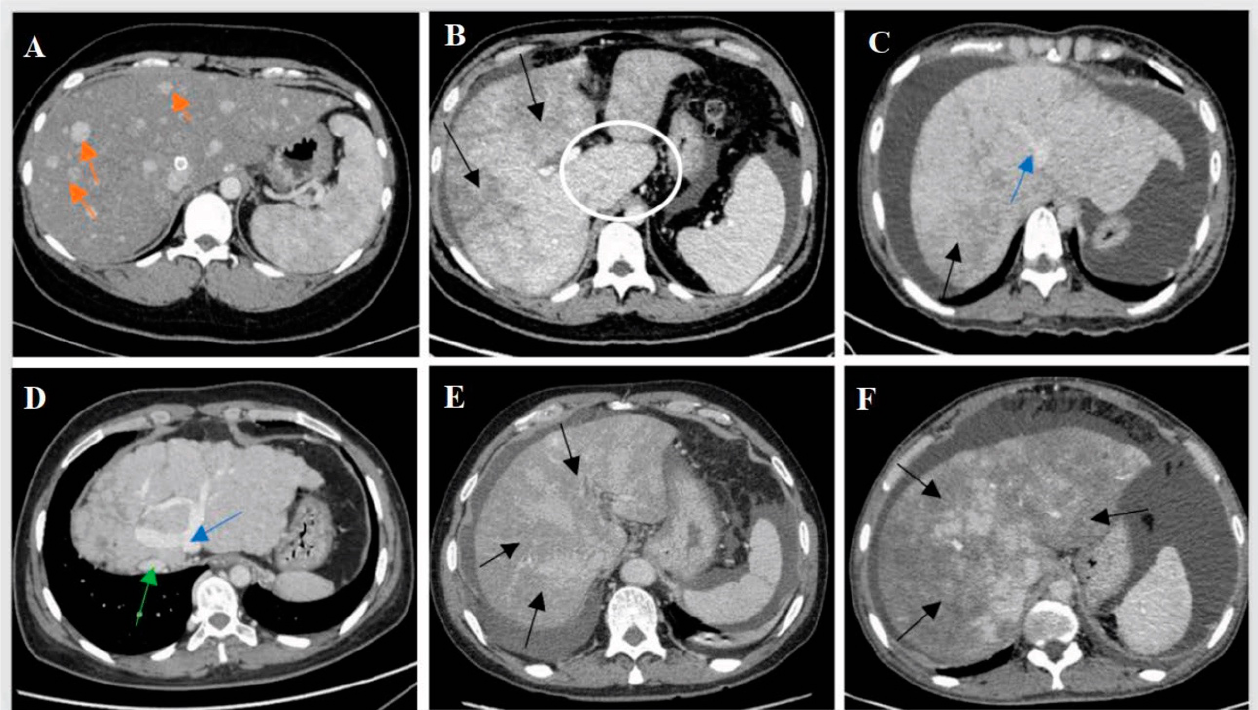
Figure 2. Patients diagnosed with BCS-HV and PA-HSOS underwent contrast-enhanced CT scans.